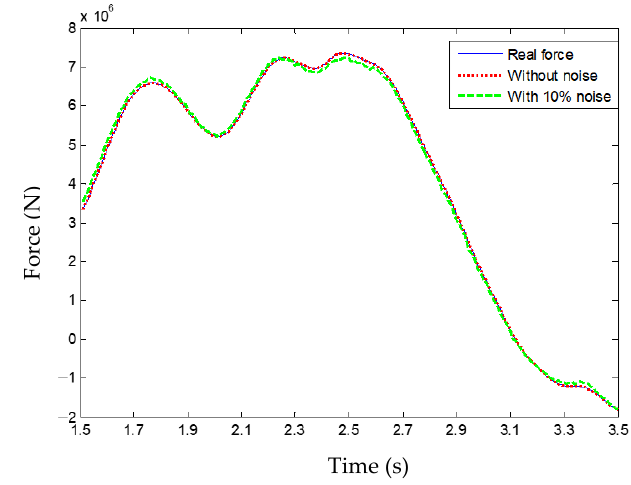
Figure 10. Force identification result (scenarios 5 and 6).